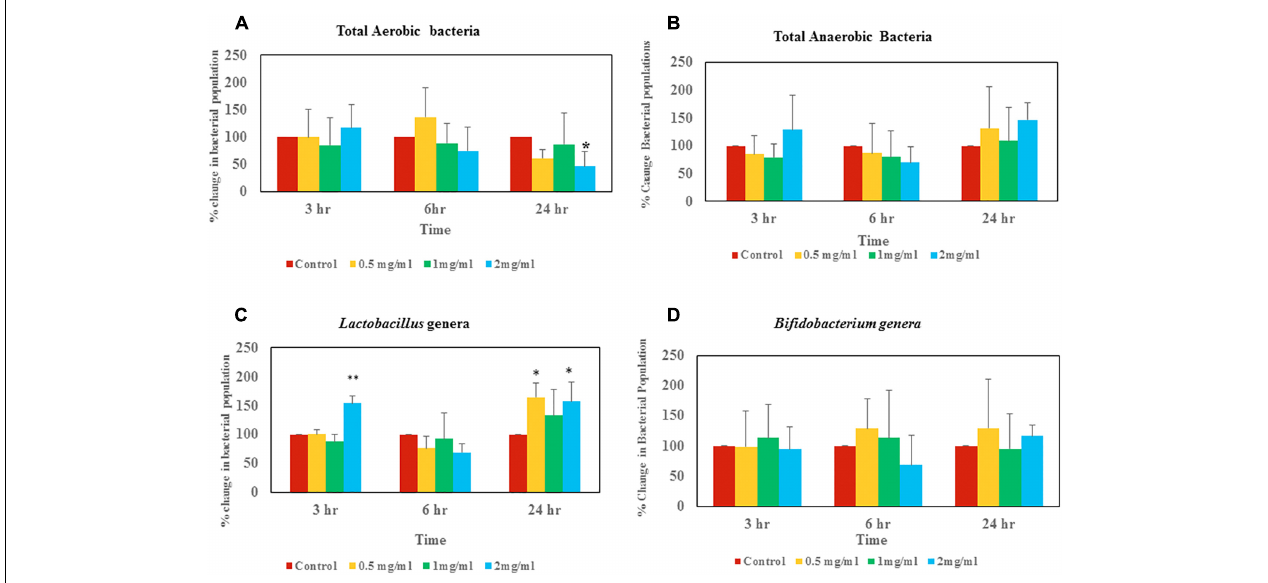
FIGURE 3 | Changes of live bacterial counts after aloin exposure in rat fecal samples. The data show % change in live bacterial population compare to control. (A) Aerobic live bacterial counts after aloin treatment, (B) anaerobic live bacterial counts after aloin exposure, (C) live Lactobacillus genera counts under microaerophilic environment after aloin exposure, and (D) live bacterial counts of Bifidobacterium genera after aloin exposure. The data shown here are average of four individual experiments. Values of p < 0.05 or below indicated as a statistical significance. Asterisks indicates statistical significance ( ∗ p < 0.05, ∗∗ p <